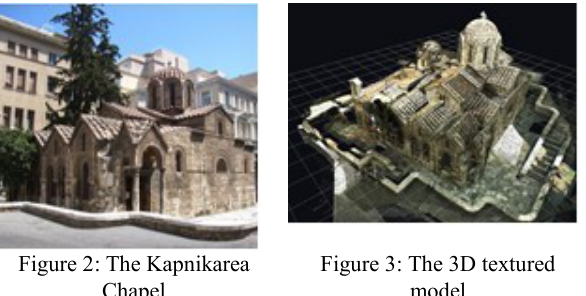
Figure 2: The Kapnikarea Chapel